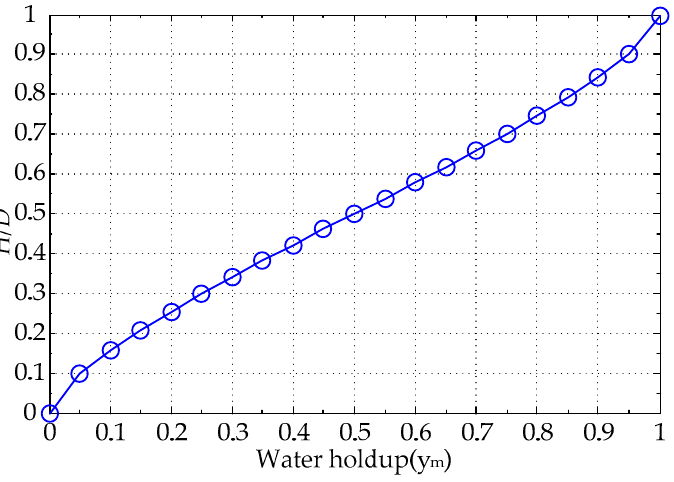
Figure 13. Water holdup y m and ( H / D ) curve.